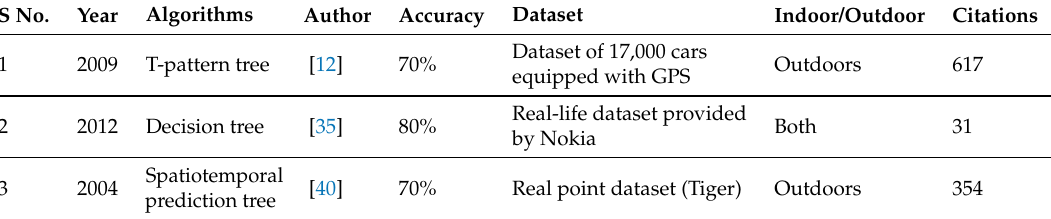
Table 4. T-pattern tree.